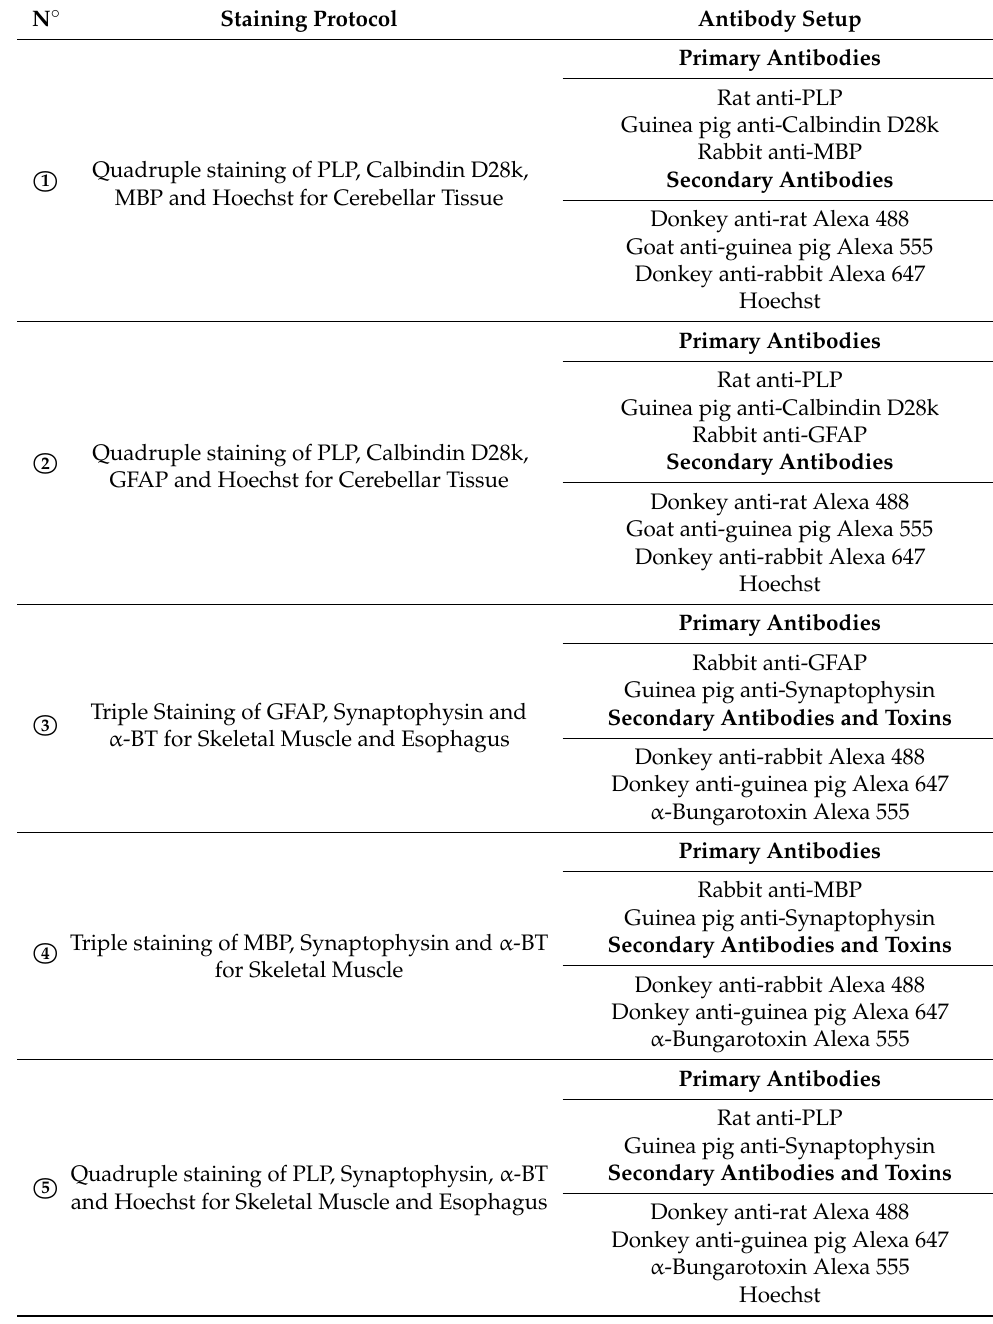
Table 1. Synopsis of applied staining protocols for frozen sections including each antibody setup. N